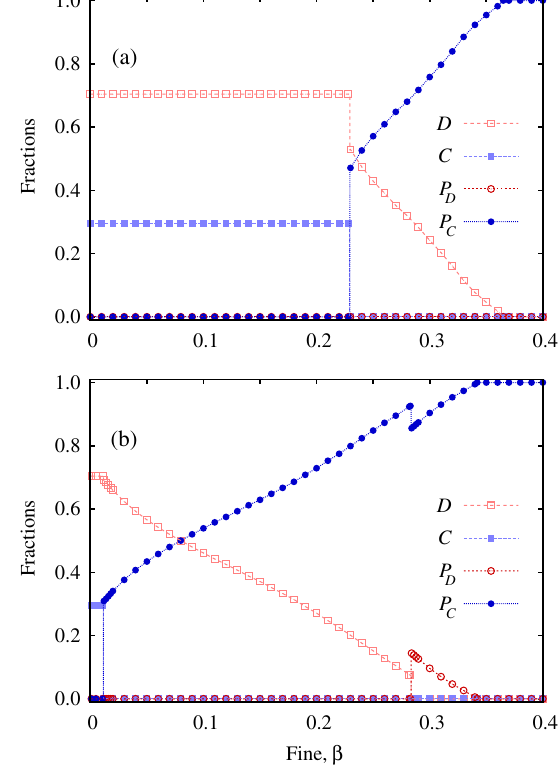
FIG. 2. Two representative cross sections of the phase diagram depicted in Fig. 1, as obtained for the punishment cost γ ¼ 0 . 4 (a) and γ ¼ 0 . 02 (b). Depicted are stationary fractions of the four competing strategies dependent on the punishment fine β .